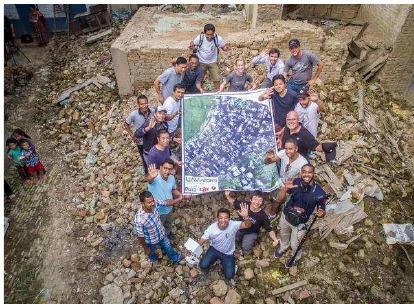
Figure 1. The 3D map of a destroyed village with the help of DJI drones in the 2015 Nepal earth- quake.